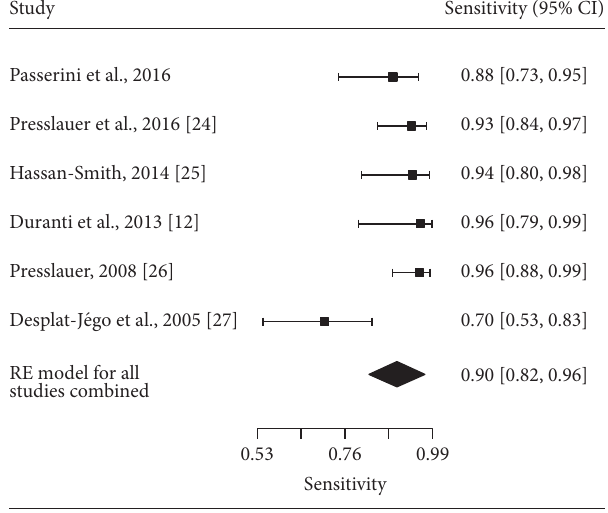
Figure 4: Forest plot of sensitivities for studies using KFLC index to diagnose MS. Summary estimate for sensitivity is computed using the approach described by Reitsma et al.